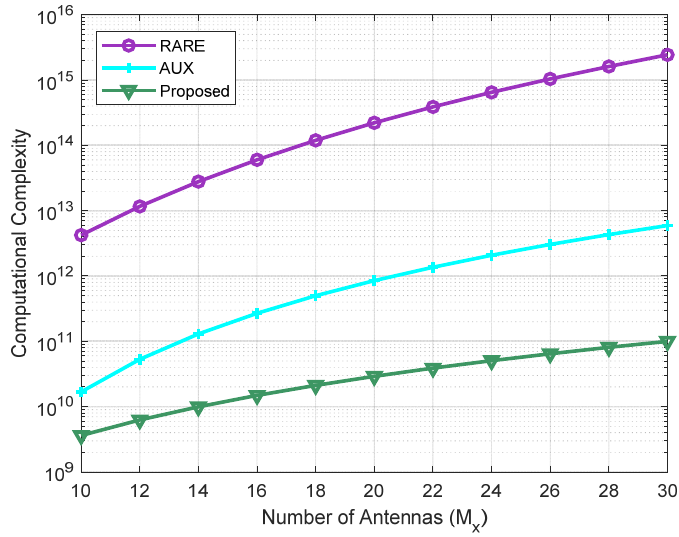
Figure 5. Computational complexity of the four methods versus number of antennas.